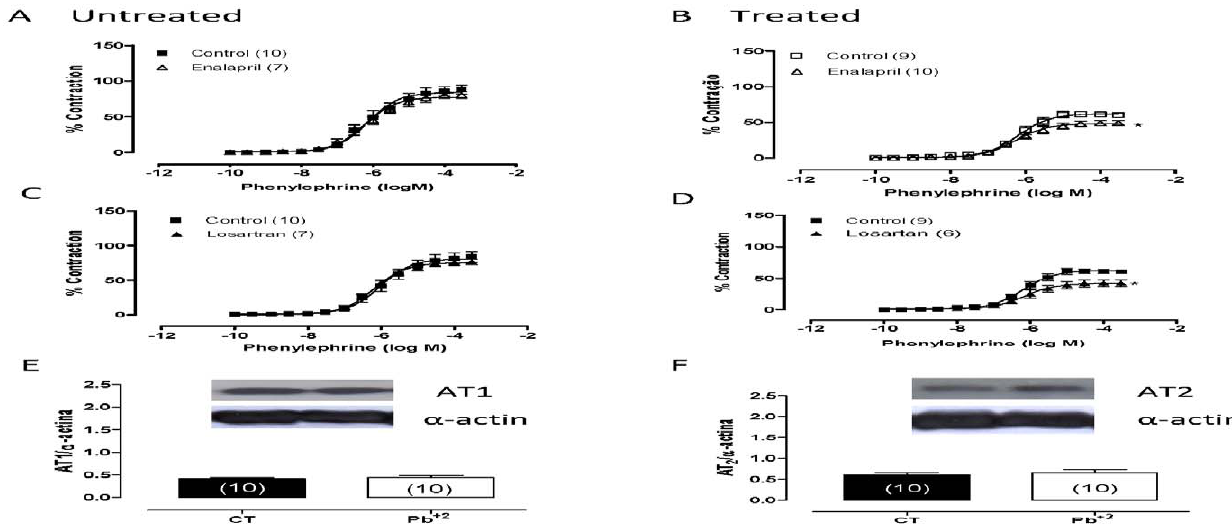
Figure 5. Effect of losartan (10 m M) (A, B) and enalapril (10 m M) (C, D) on the concentration-response curves to phenylephrine in endothelium-intact aortic segments from untreated (CT) and lead-treated rats (Pb + 2 ). Densitometry analyses of the western blots for receptors AT 1 (E) and AT 2 (F) in aortas from untreated (CT) and lead-treated rats (Pb + 2 ). Representative blots are also shown.*P , 0.05 by Student’s t- test. Number of animals used is indicated in parentheses.